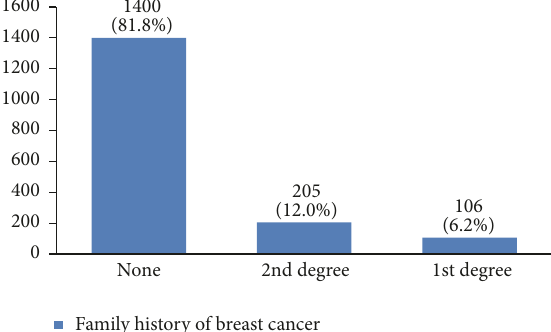
Figure 6: The parity of the studied breast cancer cases.